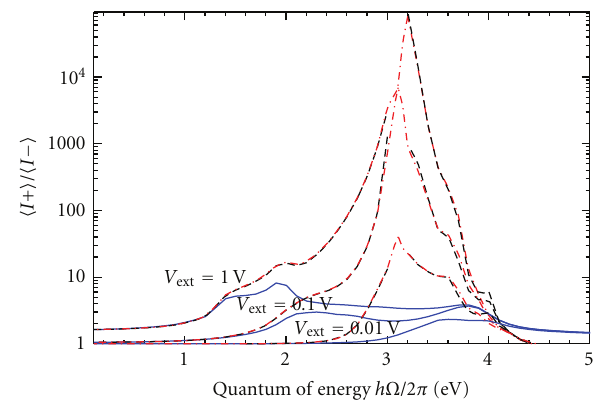
Figure 16: Rectification ratio of a junction made of silver and subject to an external bias V ext ( t ) = V ext cos( Ω t ), with V ext = 1, 0.1 and 0.01V (downwards, as indicated). The solid, dashed and dot- dashed lines indicate results indicate results achieved respectively with ε ( Ω ) = −∞ , ε ( Ω ) = 1 − Ω 2 p / Ω 2 , and ε ( Ω ) = 1 − Ω 2 p / ( Ω 2 + i Ω /τ ) as models for the dielectric function of the tip. Results obtained at the 3.1 eV resonance energy with ε ( Ω ) = 1 − Ω 2 p / Ω 2 Figure 14: (Color online) Rectification ratio as obtained for a as model for the dielectric function of the tip are not represented geometrically asymmetric junction subject to an external bias t ) = V Ω t ) with V V = 1 (solid line), 0.1 (dashed ) ext ( ext cos( ext and 0.01 V (dot-dashed line). The quantum of energy (cid:2) Ω ranges between 0.2 and 5eV. The vertical lines indicate the height of the surface barrier (as measured from the Fermi level of the emitting metal) when V ext ( t ) = 1 (dashed line, left), − 1 (dashed line, right), and 0V (solid Line) [18].